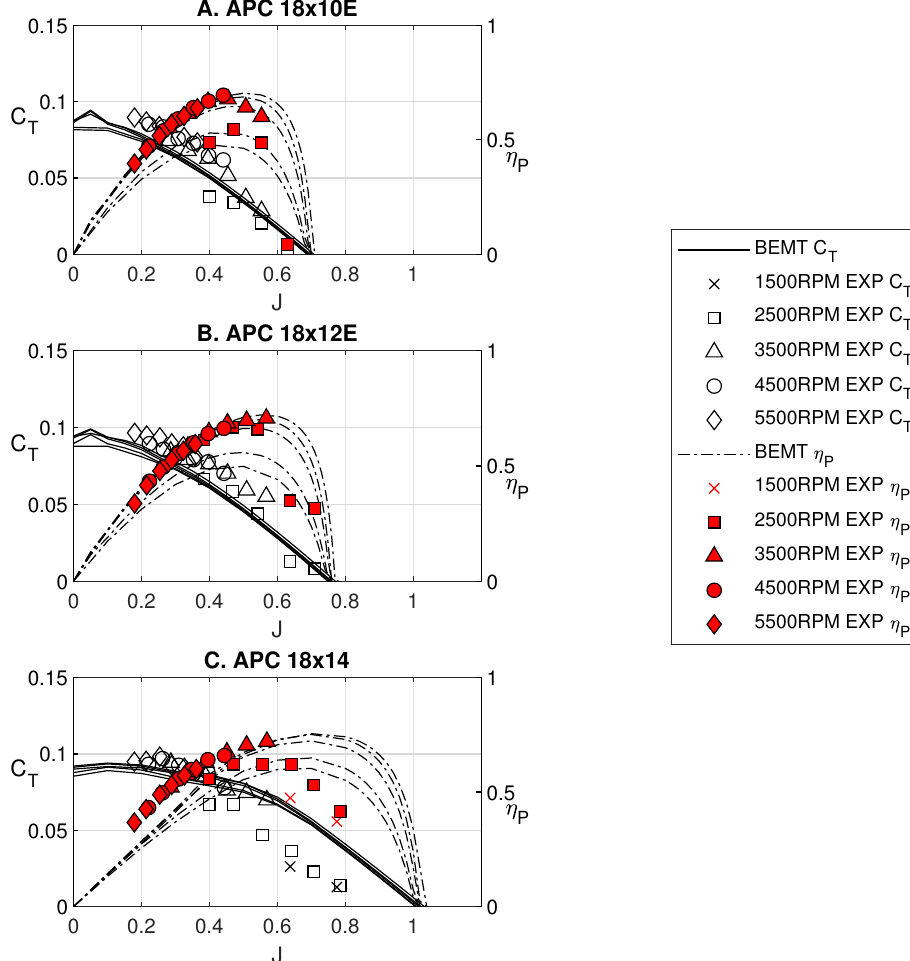
Figure 13. BEMT and experimental C T and η P for APC propellers 18 × 10E, 18 × 12E, and 18 ×